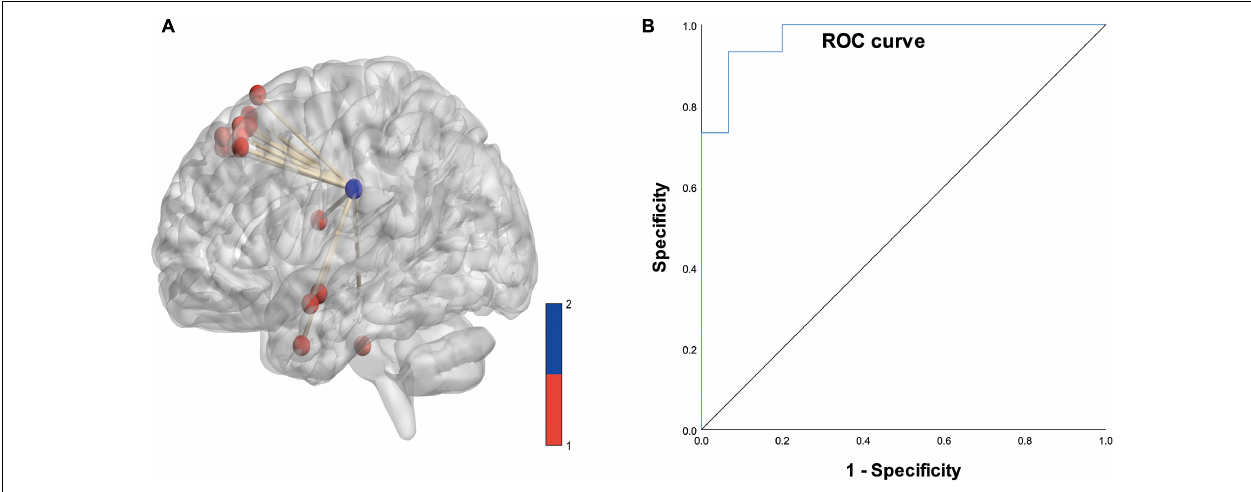
FIGURE 7 | (A) Diagram of the functional covariance connections between the left superior corona radiata and gray matter voxels. Red spheres represent gray matter voxels, and the blue spheres represent the left superior corona radiata. (B) ROC curve based on the connections between the left superior corona radiata and the gray matter voxels (area under the curve is